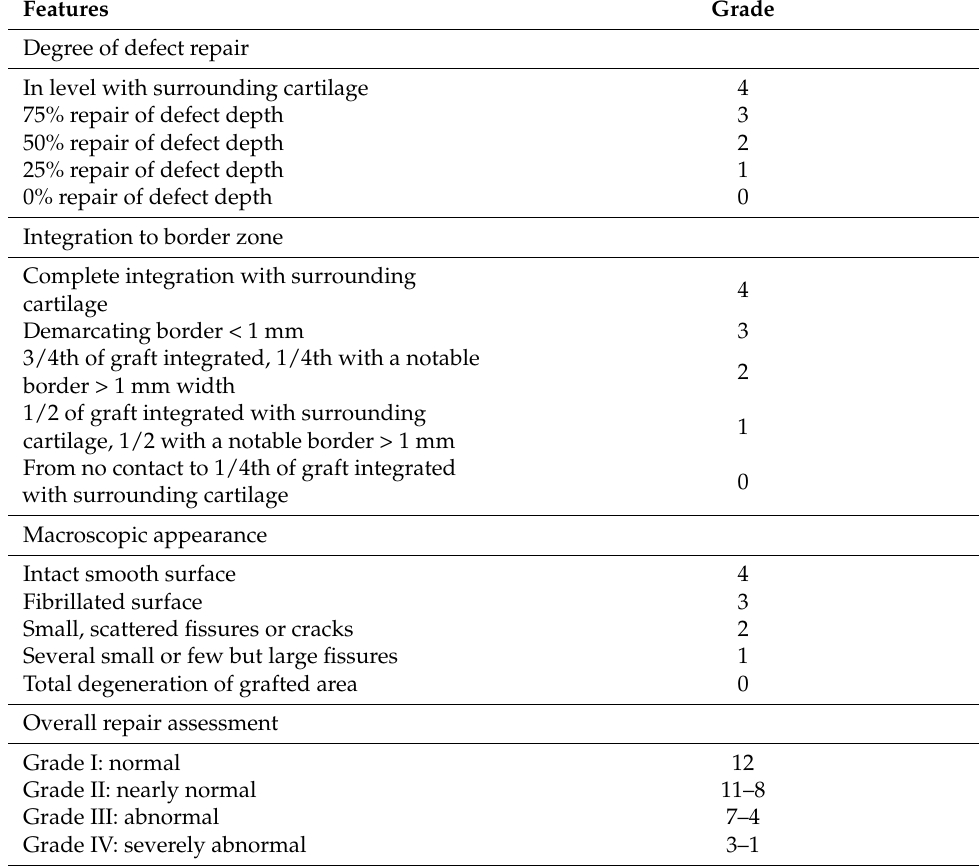
Table 2. International Cartilage Repair Society macroscopic evaluation of cartilage